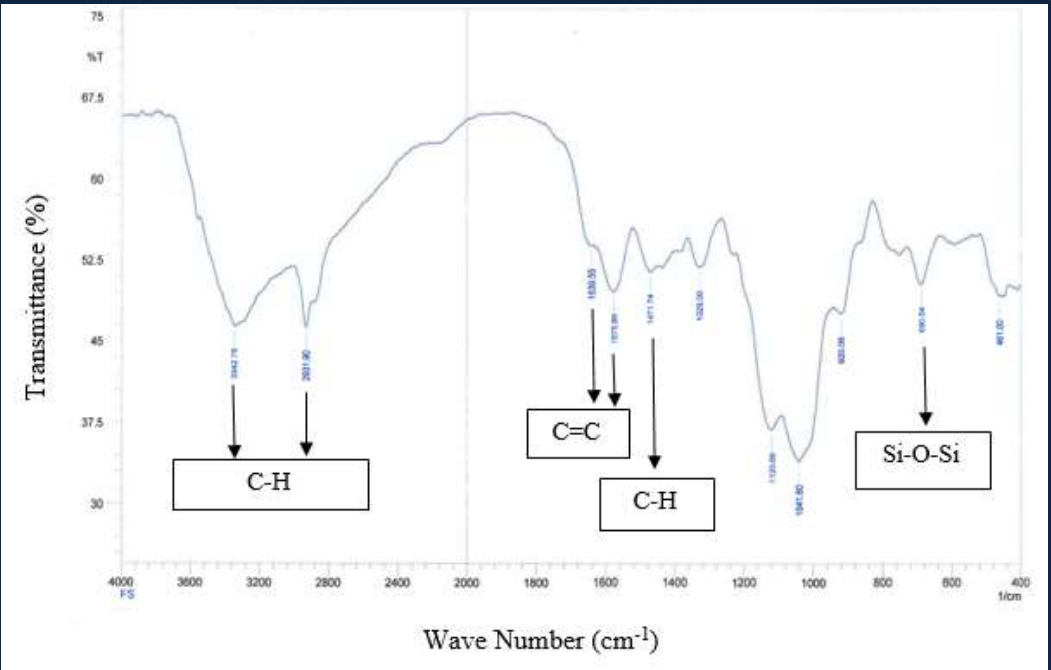
Figure 4 : FTIR spectra of sisal fibers after